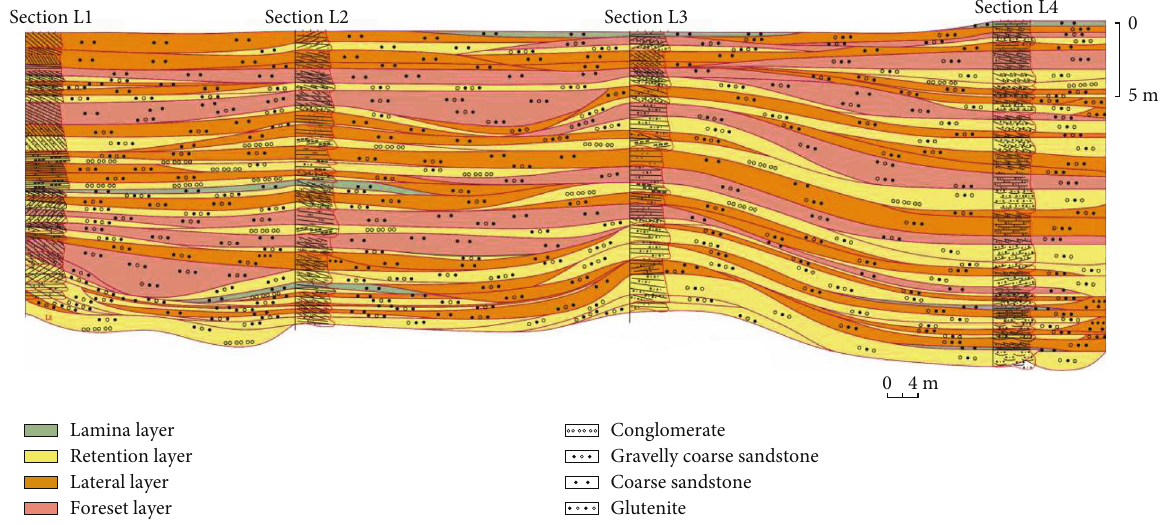
Figure 5: Outcrop characteristics of the Jurassic Ahe Formation in the Kezilenuergou area